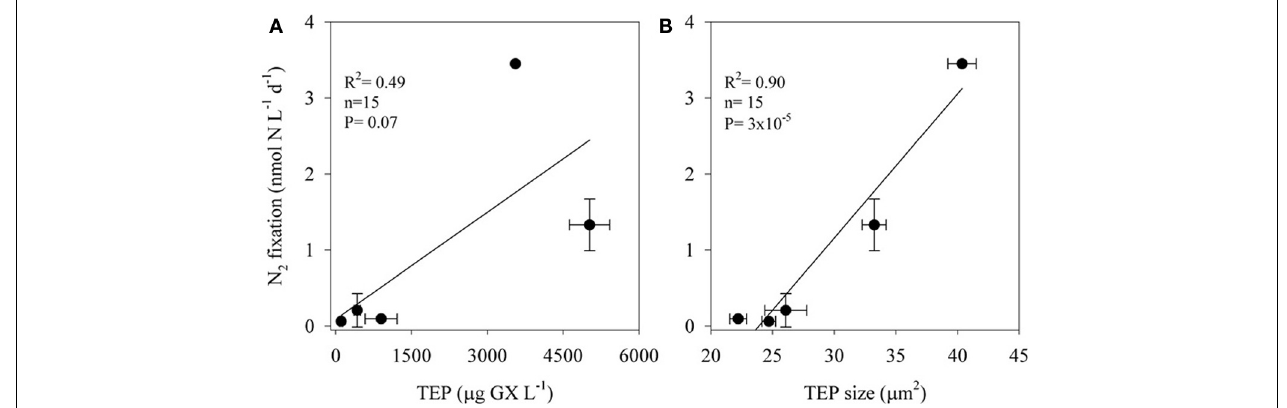
FIGURE 3 | The relationship between N 2 fixation rates of aphotic diazotrophs and transparent exopolymer particles (TEP) concentrations (A) and size (B) in experimental manipulations of LB waters from 250m